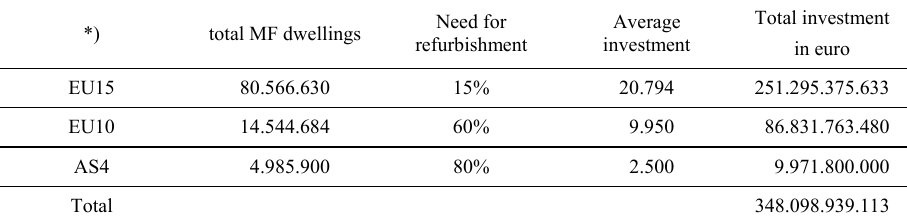
Table 4: need for investment in housing refurbishment in 2004